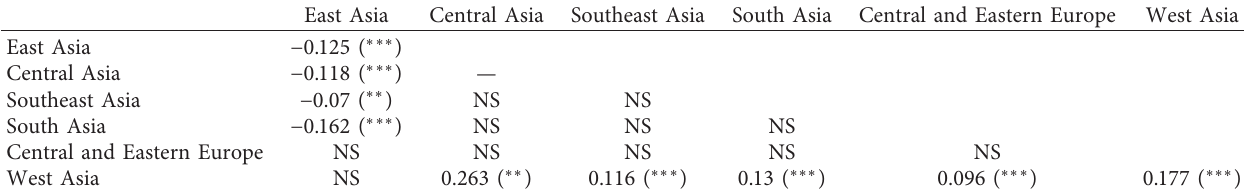
Table 12: Results of OLS regression analysis of trade within and between subregions.